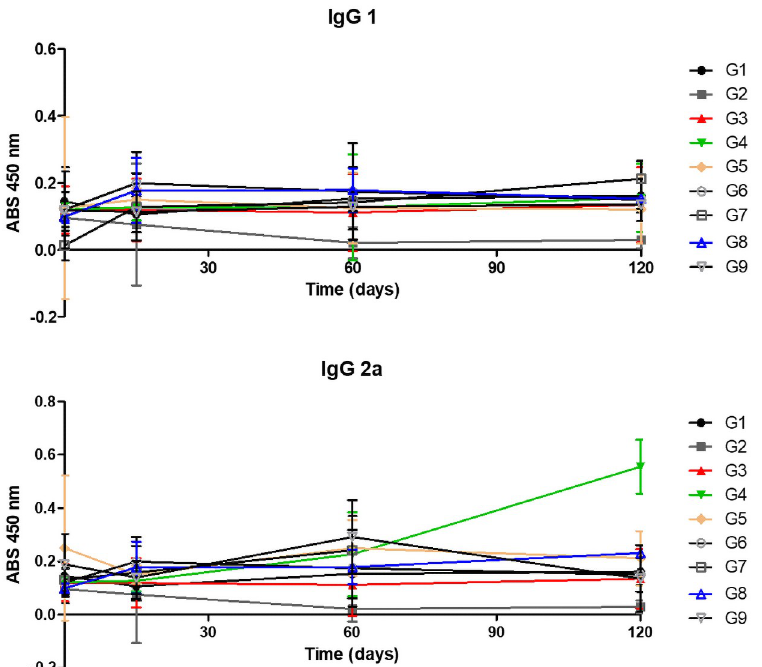
Fig 8. IgG1 and IgG2a antibodies levels in mice immunized with different peptides. The results are presented as the mean and standard deviation (bars) of absorbance (nm) in the indirect ELISA assay for each experimental group with 12 animals. G1—inoculated with PBS; G2—inoculated with Saponin; G3—inoculated with Peptide 1 + saponin; G4— inoculated Peptide 2 + saponin and G5—inoculated with Peptide 3 + saponin; G6—inoculated with Peptide 4 + saponin; G7—inoculated with Peptide 5 + saponin; G8—inoculated with Peptide 6 + saponin and G9—inoculated with rCP40 + saponin. The blood was collected and evaluated on day 0 (pre-immune) and day 15 (before the